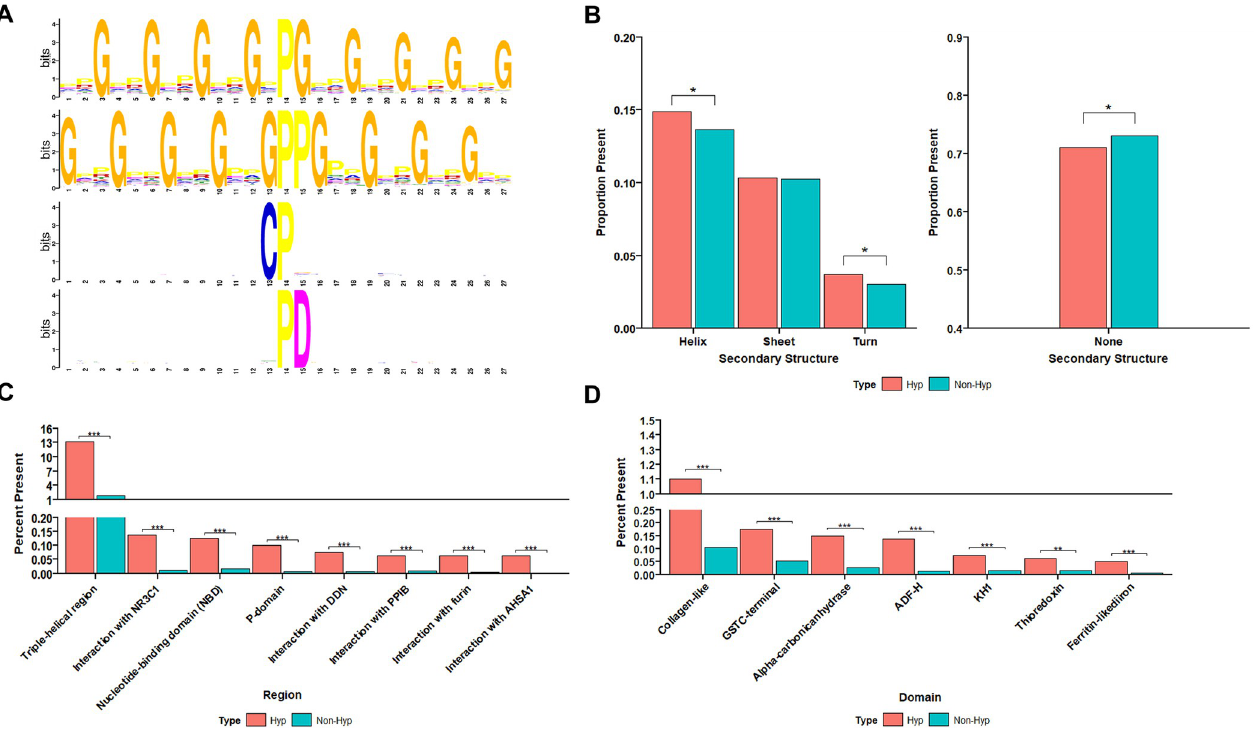
Fig 4. Motif and protein feature analysis of HypDB. (A) Motif enrichment analysis with the flanking sequences of Hyp sites identified PG, GPPG and CP motifs (adj p < 10 − 6 ) and repeated analysis with the flanking sequences of Hyp sites after filtering out PG motif sequences identified PD motif (adj p < 10 − 6 ). (B) Secondary structure enrichment of Hyp sites based on PDB protein structures ( � p < 0.05). (C) Functional region enrichment analysis of Hyp sites based on region localizations on proteins in UniProt ( ��� p < 0.001). (D) Functional domain enrichment analysis of Hyp sites based on domain localizations on proteins in UniProt ( ��� p < 0.001, �� p < 0.01). Refer to the S5 and S6 Tables for the underlying data of Fig